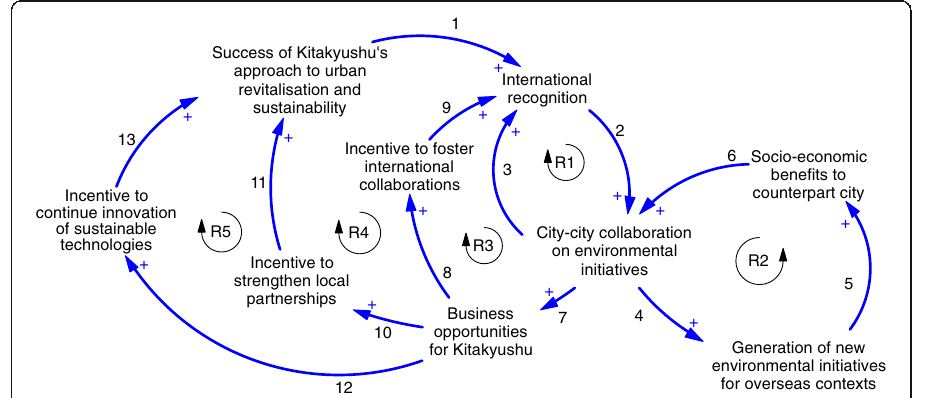
Fig. 3 Systems diagram of the effects of Kitakyushu ’ s sustainability experimentation on other cities. See Table 5 below for